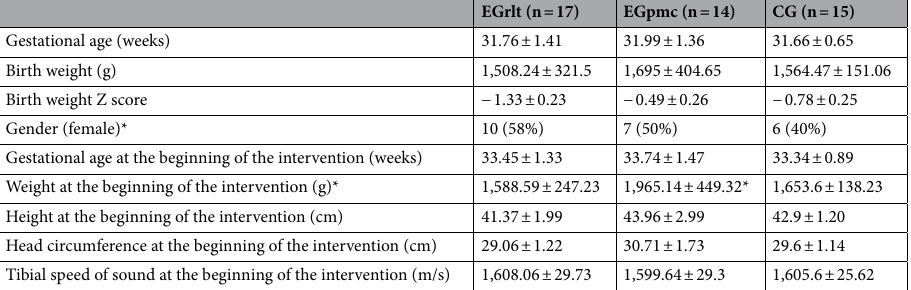
Table 1. Baseline data. *p < 0.05 for differences among groups. CG = Control Group. EGpmc = Experimental group treated with passive movements with gentle compression. EGrlt = Experimental group treated with reflex locomotion therapy. Data are presented as means ±